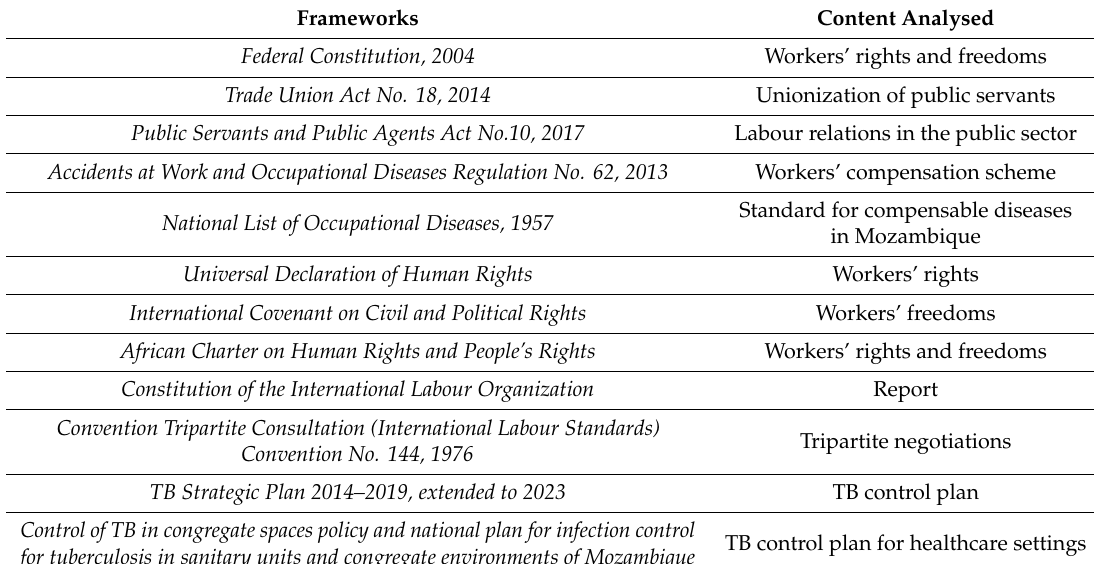
Table 1. List of analysed legal